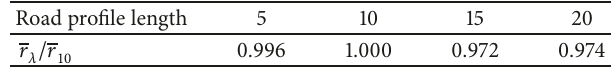
Table 3: The average ratio between the fuel consumption obtained in an online run and that obtained in a long offline run, for four different road profile lengths 𝜆 (5, 10, 15, and 20 km), normalized by the value obtained for the 10 km case. The running time for the online runs was 3.5 minutes in the case of 5 km road profiles, 7 minutes for the 10 km road profiles, and so